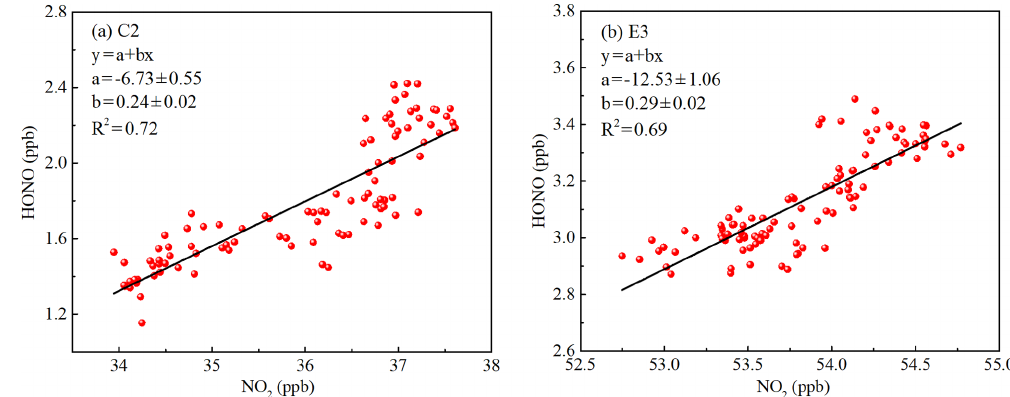
Figure 8. The correlation of the vertical profiles between HONO and NO 2 during (a) the clean episode (C2) and (b) the haze episode (E3) using a linear least squares regression fit.